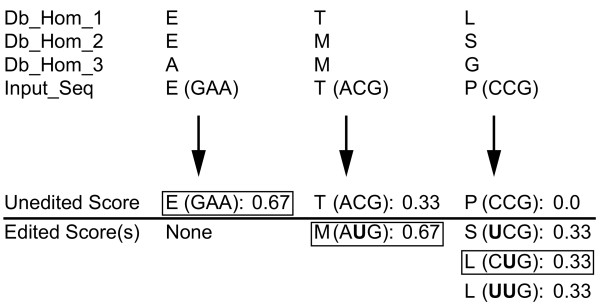
Score calculation and prediction of RNA editing. The hypothetical alignment shows an input sequence aligned to three homologues from the Aligned Sequence Database. The predicted state is boxed. Column 1 shows a case where RNA editing is not possible. Column 2 presents a case where the editing state is more strongly supported. Column 3 demonstrates the various rules placed on the algorithm. The CUG is taken as the correct state because it requires fewer edits than UUG and is edited at the second position, whereas UCG is edited at the first position.